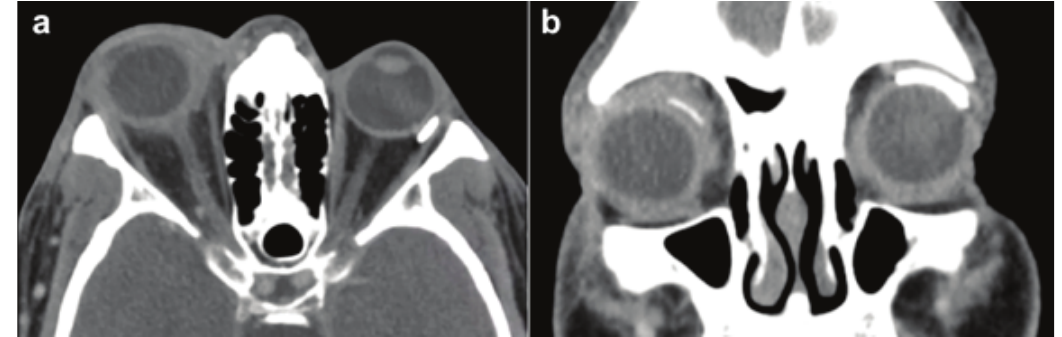
Figure 2. Contrast-enhanced computed tomography of the orbits showing findings consistent with orbital cellulitis, including proptosis of the right globe, thickening of the sclera and optic nerve insertion, small superior fluid collection, and mild anterior retrobulbar fat stranding (A). An Ahmed tube shunt and Baerveldt tube shunt are visualized in the right and left globes, respectively